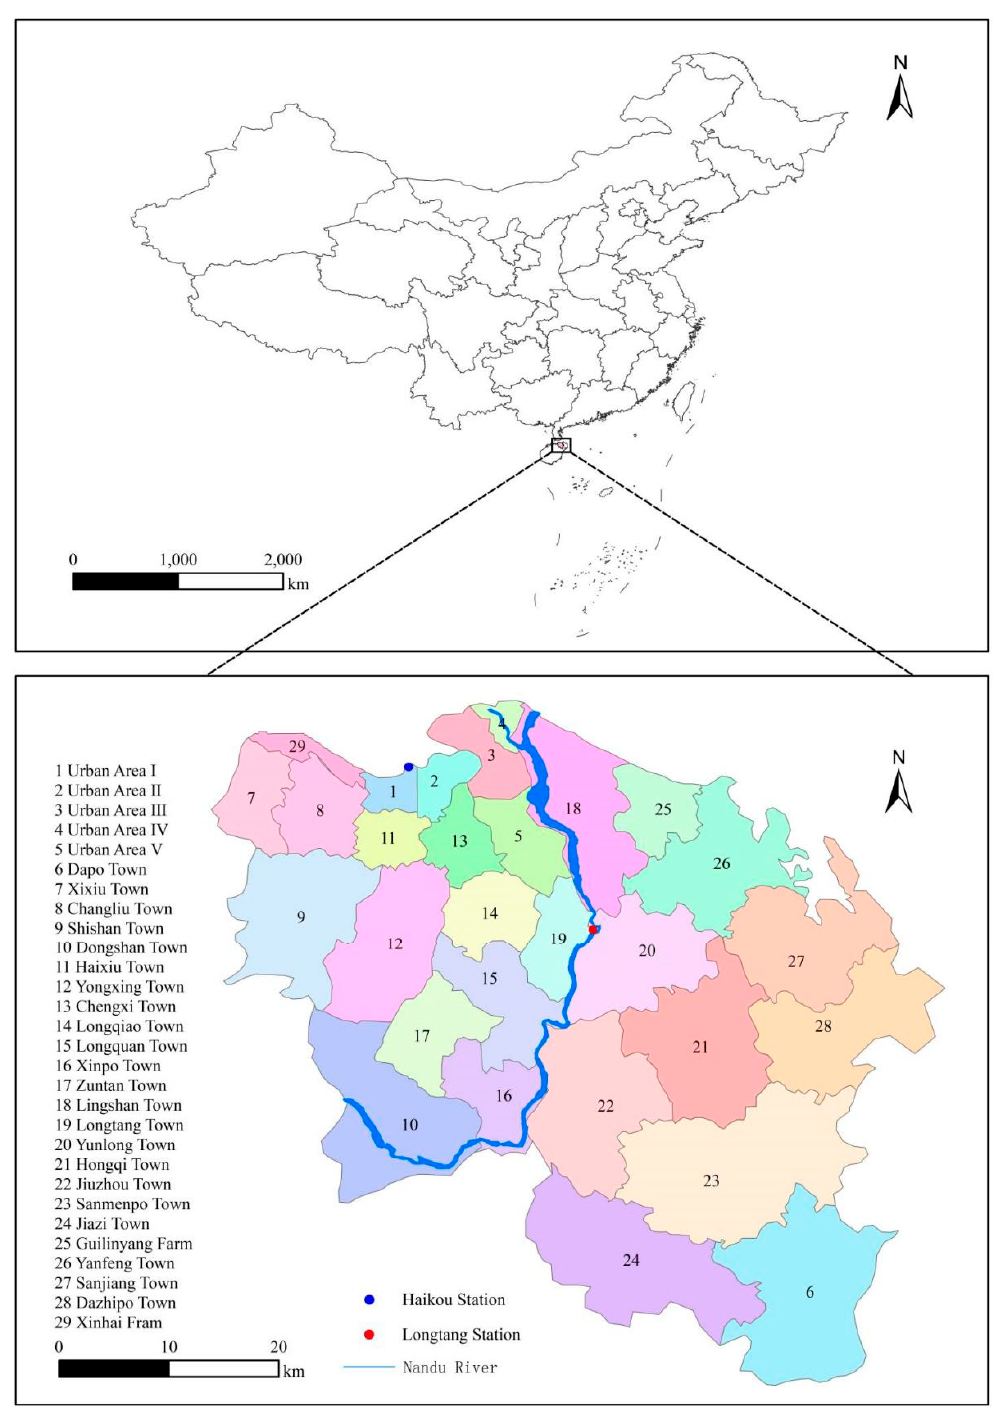
Figure 1. Location of Haikou City and the assessment units.